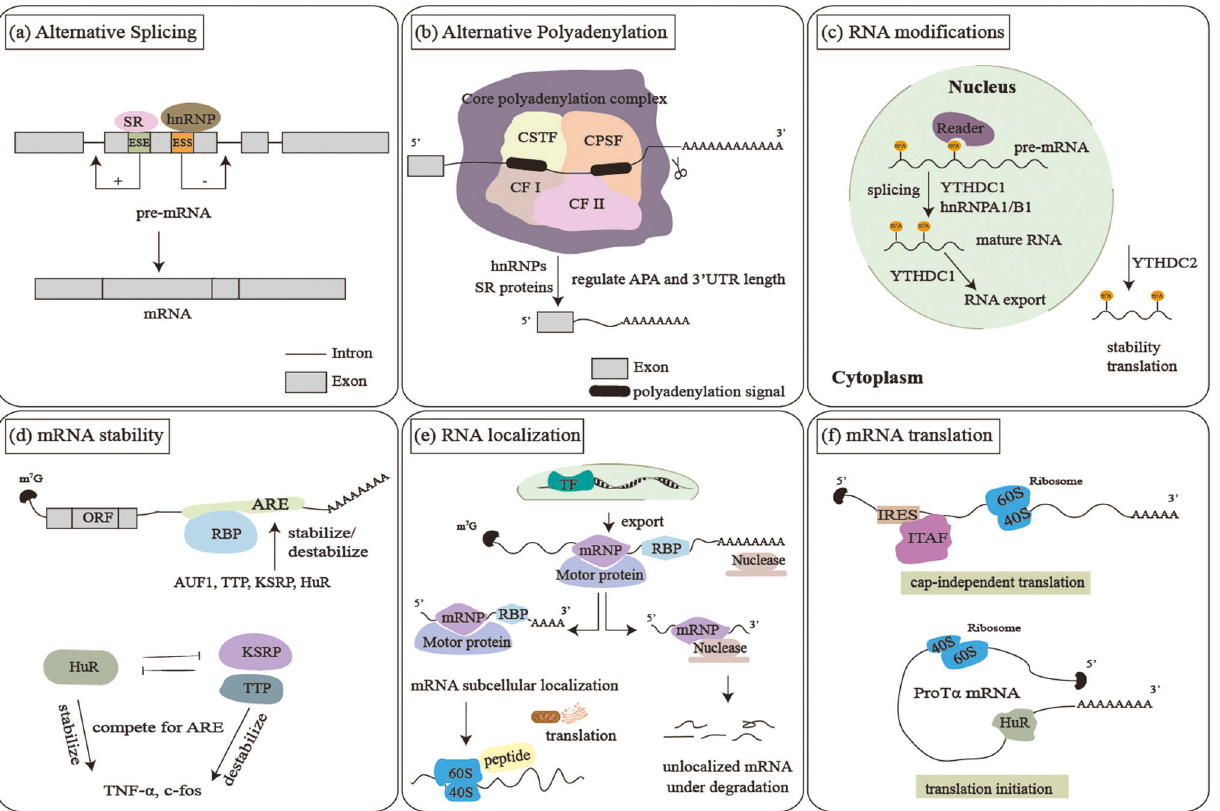
Fig. 1 Basic functions of RBPs in the post-transcriptional regulation of gene expression. RBPs can determine the fate of RNAs by controlling various events. Schematic diagrams of the functions of RBPs and the representative ones are shown in a alternative splicing, b alternative polyadenylation, c RNA modi fi cations, d mRNA stability, e RNA localization, f mRNA